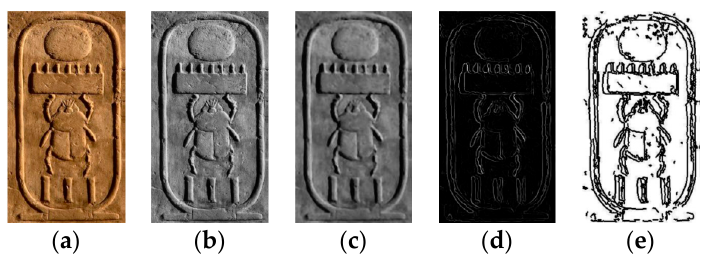
Figure 5. ( a ) Original image; ( b ) grayscale image; ( c ) median filter; ( d ) Canny edges; ( e ) threshold ISODATA inverted. ISODATA